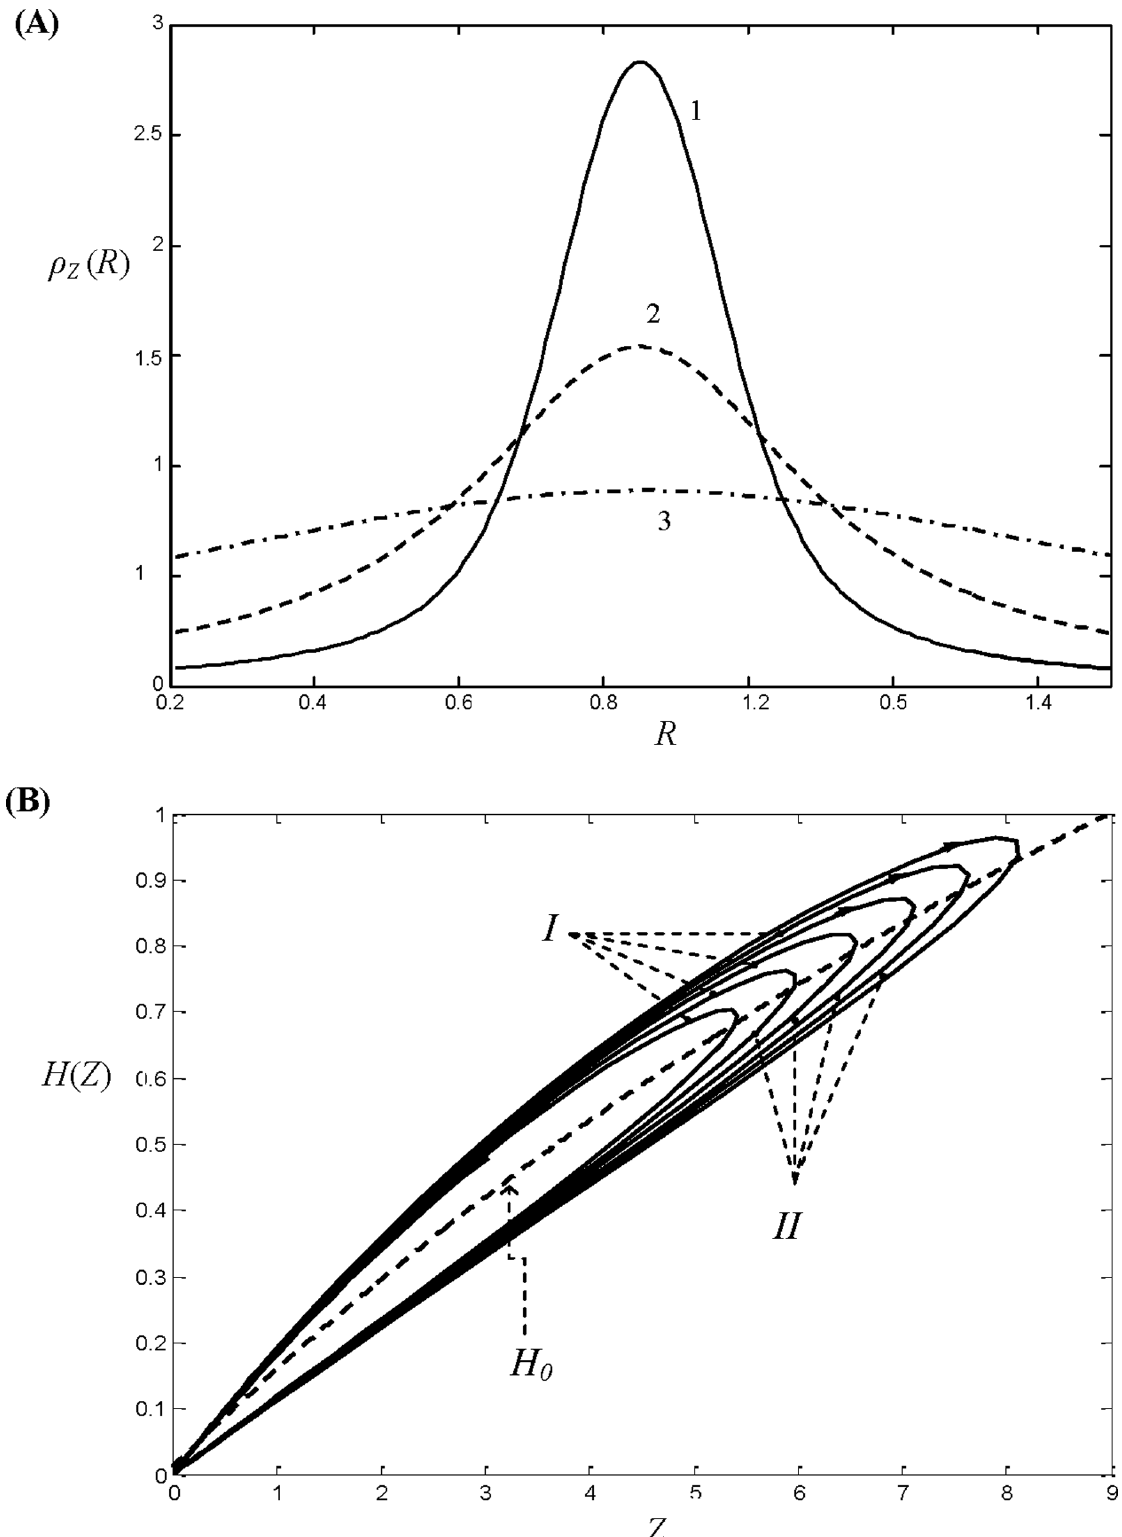
Figure 5. Revealing the mechanism of stabilization in the predator-prey model (1)–(2). The trade-off function a ( R ) is given by (8) with a 0 =1; Da = 2 2. (A) Evolution of the life history trait distribution for the prey population though a cycle. Curves 1 and 3 correspond to the minimal and the maximal predator density though a cycle; whereas curve 2 shows r Z ( R ) for an intermediate density of predator. An increase of predator biomass results in a prevalence of prey cohorts with low vulnerability to predation. (B) The overall functional response of the predator as a function of